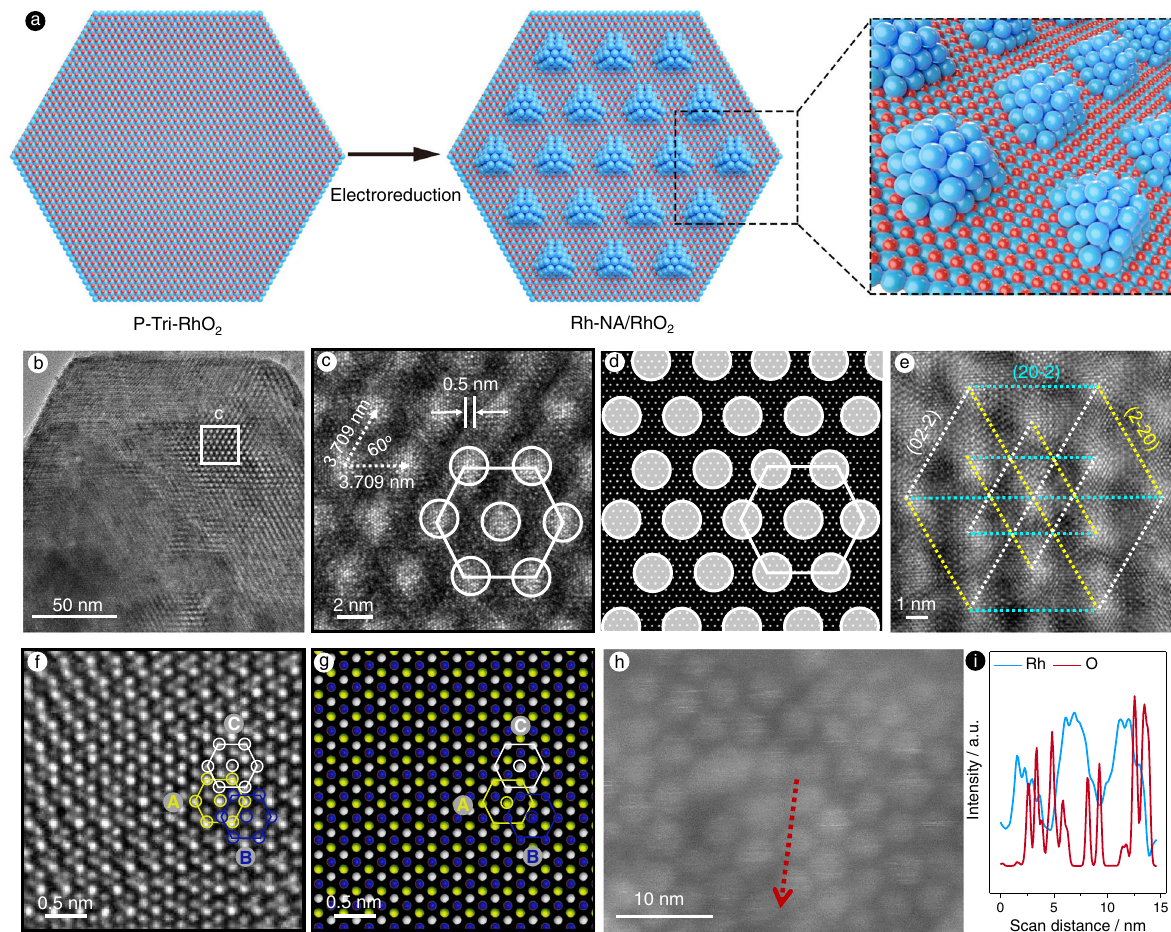
Fig. 2 | Structure characterization of Rh-NA/RhO 2 . a Schematic representation for in-situ growth of molecular-scale-spacing, well ordered and single crystal- line Rh array on substrate of P-Tri-RhO 2 to obtain Rh-NA/RhO 2 electrocatalyst. b The STEM image of Rh-NA/RhO 2 and ( c ) its partial enlargement, clearly showing single crystalline Rh atom array on the surface of P-Tri-RhO 2 . d Simulatedpatternfor( c ). e TheenlargedSTEMimagesofRh-NA/RhO 2 ,clearly showing {220} crystal lattices of Rh particles with well ordered arrangement: